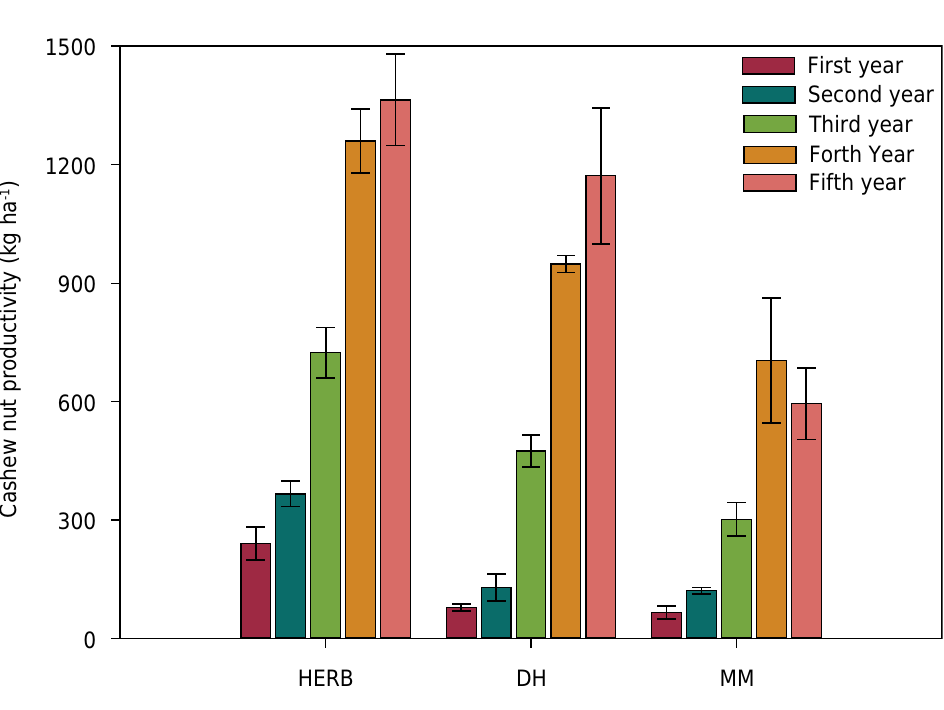
Figure 5. Cashew nut productivity under different management systems in an area cultivated with early dwarf cashew in Pacajús, Ceará, Brazil. Data from the first four years of cultivation were adapted from Ribeiro et al. (2007). Error bars represent the standard error of the mean (n = 3). HERB: herbicide; DH: disc harrowing + crowning; and MM: mechanical mowing +